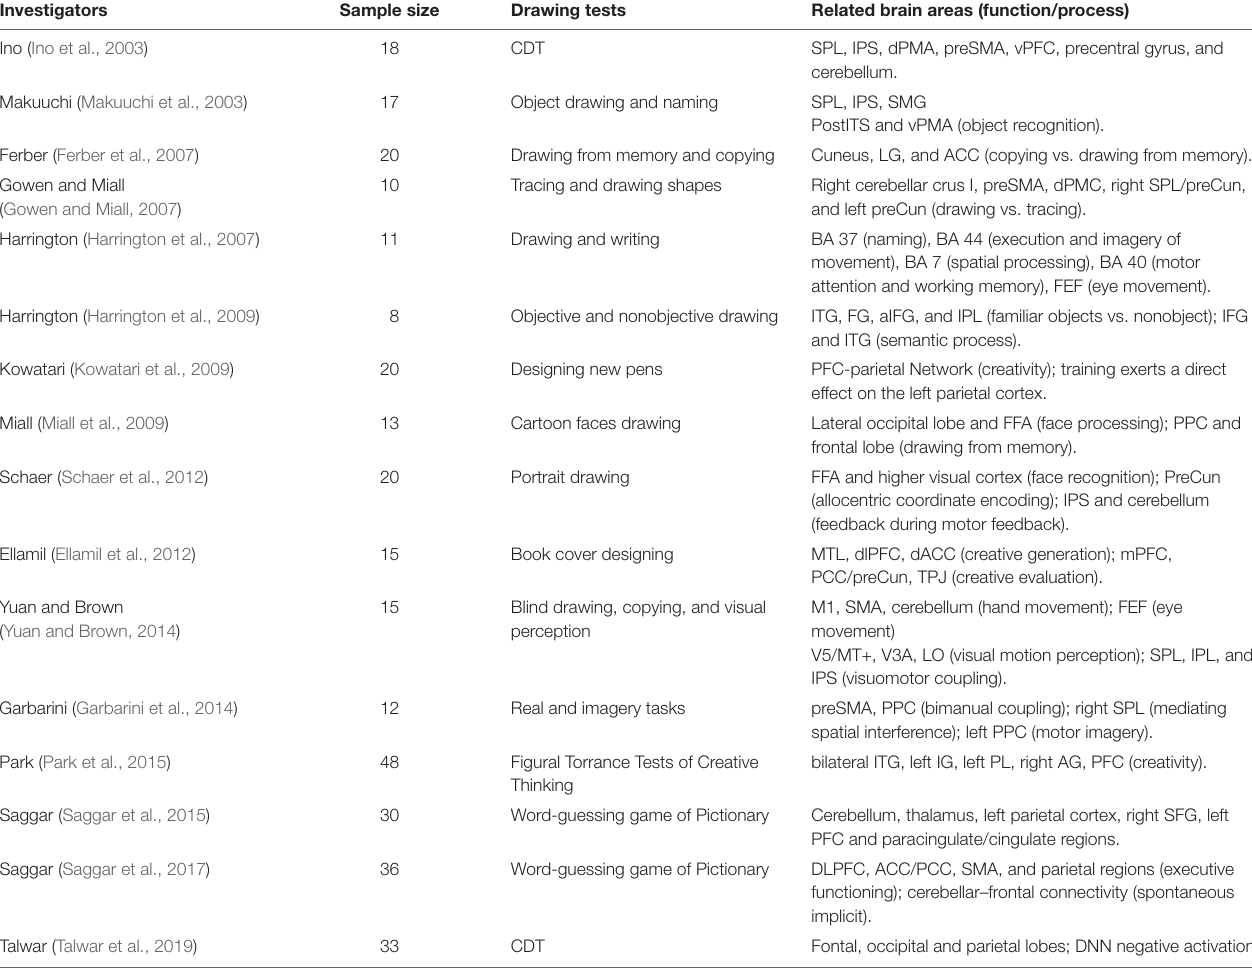
TABLE 2 | The activation of the PPC in drawing tests from fMRI studies.